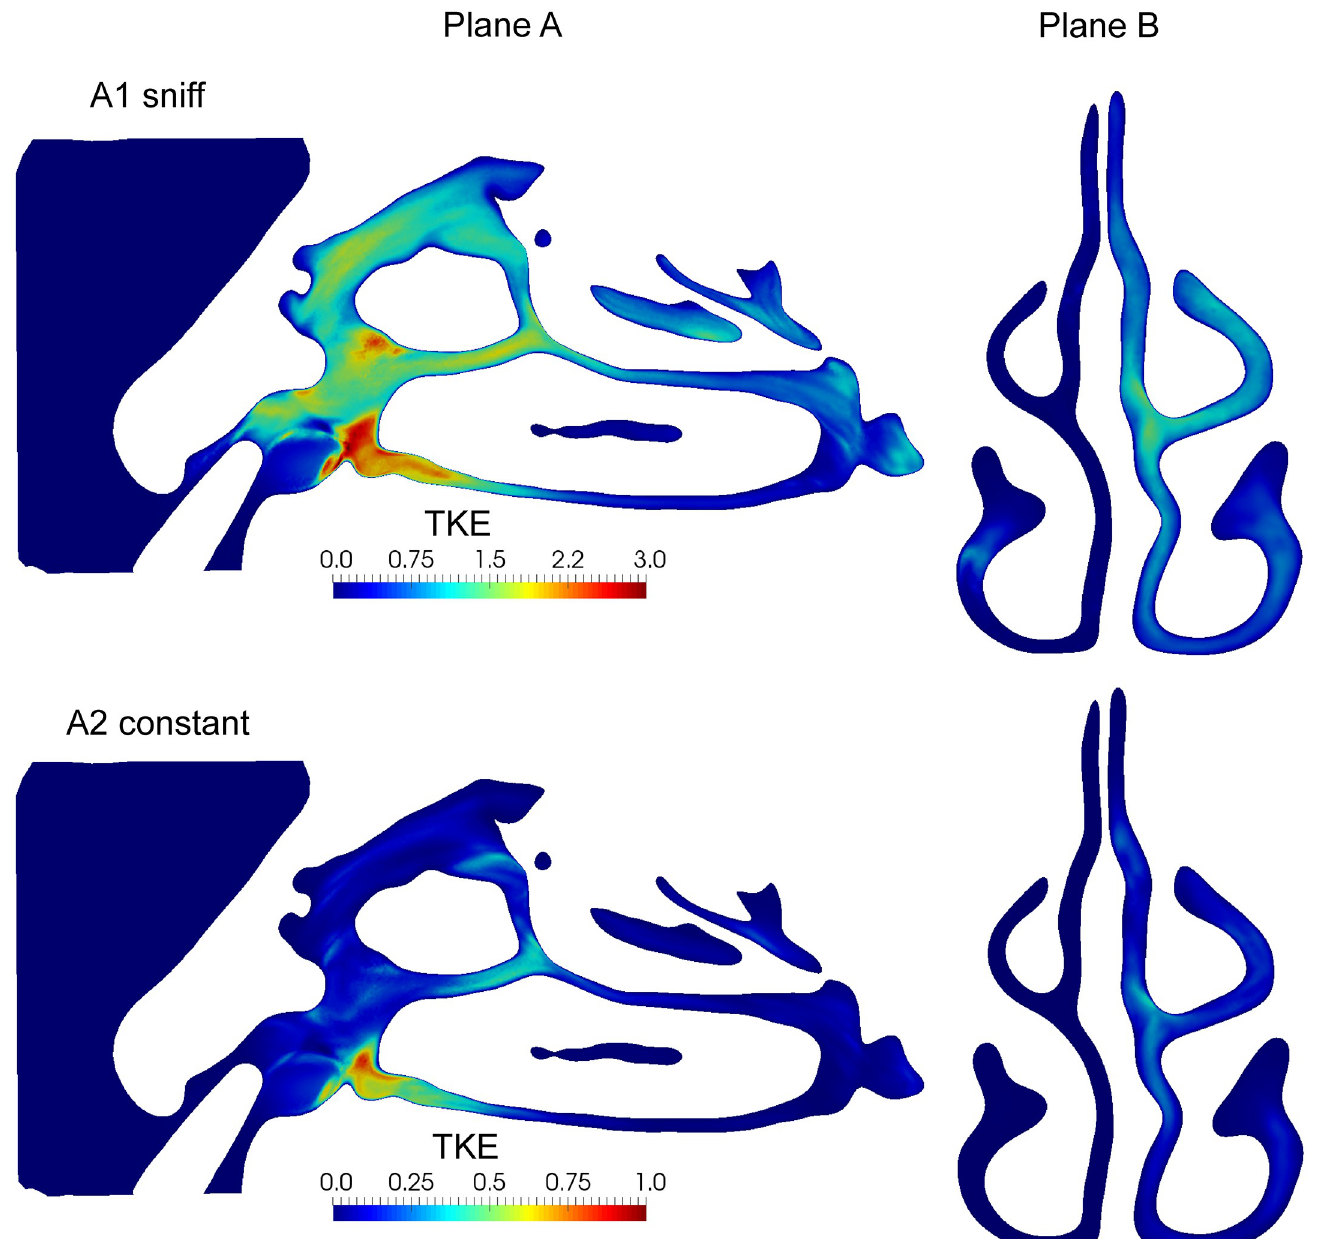
Fig 12. Turbulent kinetic energy (m 2 /s 2 ) of sagittal plane of left nasal cavity (plane A) and coronal plane in the middle of nasal cavity (plane B) computed for the time period [0.1-0.15s] for A1 and A2 inhalation conditions.